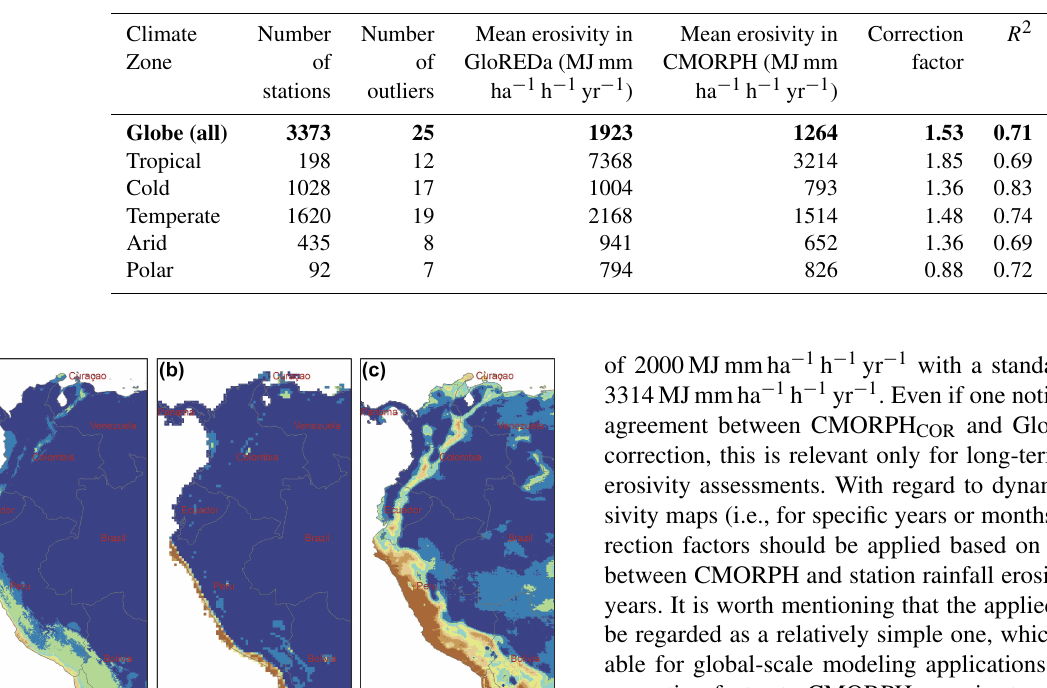
Table 5. Correction factors that were developed based on the GloREDa–CMORPH relationship per climate zone. R 2 is the coefficient of determination. Bold text shows global area.